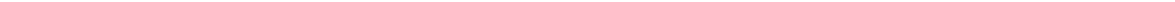
Fig. 1 BRCA2 depletion accelerates the dissolution of RPA2 foci and causes massive nuclear fragmentation. a HeLa cells were transfected with control siRNA or siRNAs against BRCA2. Forty-eight hours post transfection, cells were exposed to 10 Gy IR and then allowed to recover for the indicated time periods before being processed for immuno fl uorescence using antibodies against RPA2 and RAD51. Representative RPA2/RAD51 foci and DAPI-stained nuclei are shown. b Quanti fi cation of RPA2/RAD51 foci and nuclear fragmentation. Data represent mean ± SEM of three independent experiments. Over 100 cells were counted in each experiment. c Knockdown ef fi ciency of BRCA2 was con fi rmed by western blotting. d BRCA2-de fi cient VC-8 cells or VC-8 cells reconstituted with wild-type BRCA2 were exposed to 10 Gy IR and then allowed to recover for 2 or 24h before being processed for immuno fl uorescence using antibodies against RPA2 and RAD51. Representative RPA2/RAD51 foci and DAPI-stained nuclei are shown. e Quanti fi cation of RPA2/RAD51 foci and nuclear fragmentation. Data represent mean ± SEM of three independent experiments. Over 100 cells were counted in each experiment. f Expression of BRCA2 was con fi rmed by western blotting. g HeLa cells stably expressing GFP-tagged histone H2B (H2B-GFP) were transfected with control siRNA or siRNA against BRCA2. Forty-eight hours post transfection, cells were exposed to 10 Gy IR. Arbitrary cells were selected between 16 and 24 h after IR and performed to visualize chromosomal dynamics by time-lapse imaging (5 min per frame, 0 = 16 h, 51 = 20.25 h).